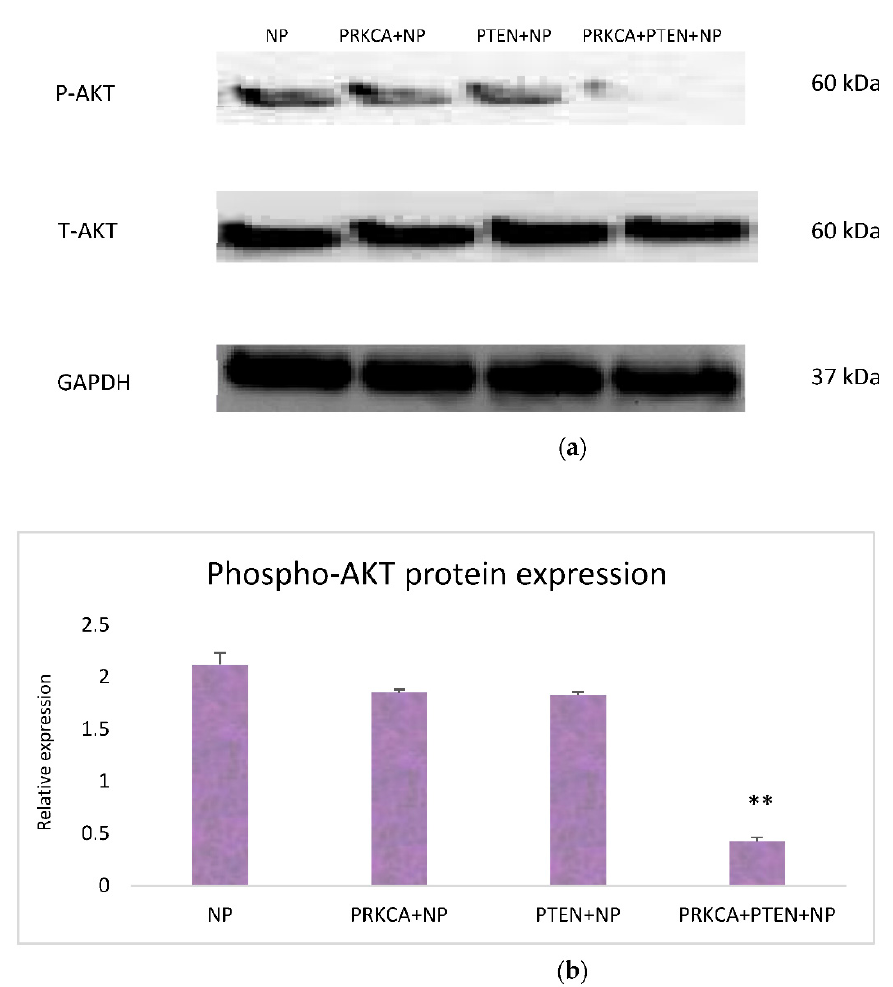
Figure 4. ( a ). Western blot images following intracellular delivery of PRKCA siRNA+ NP, PTEN+ NP and PRKCA siRNA+ PTEN+ NP in MCF-7 cell line. Cells were incubated with the treatment formulations for 48 h prior to cell lysis for protein extraction and Western blotting. Detection of Phospho-AKT (P-AKT), Total-AKT (T-AKT) and GAPDH was performed using respective polyclonal antibodies. ( b ). Densitometry analysis showing ratio of P-AKT/Total AKT expression. P-AKT expression